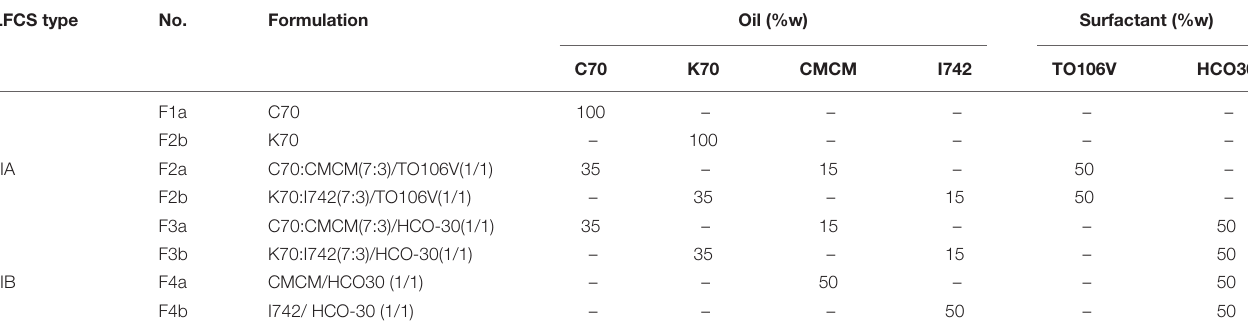
TABLE 2 | Lipid formulations classification systems (LFCS) utilized and the % (w/w) composition of excipients in each formulation in this study. LFCS